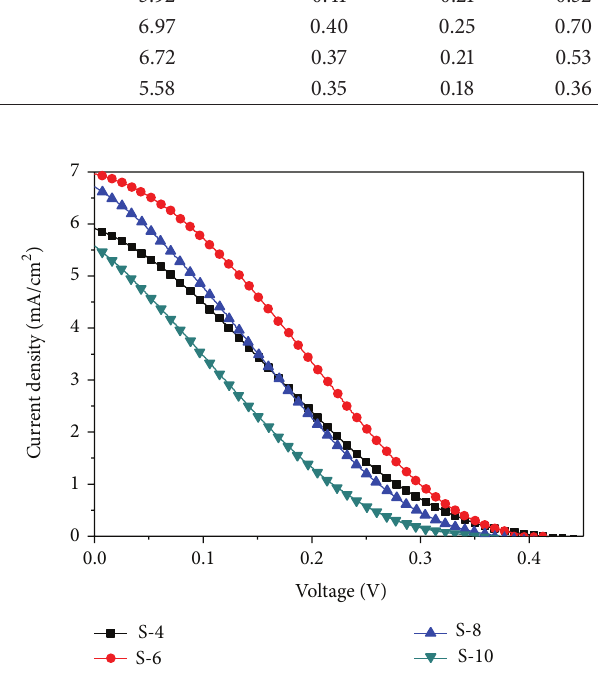
Figure 2: The 𝐽 - 𝑉 curves of different working electrodes based on La-doped CdS. The corresponding parameters are of S-4, S-6, S-8, and